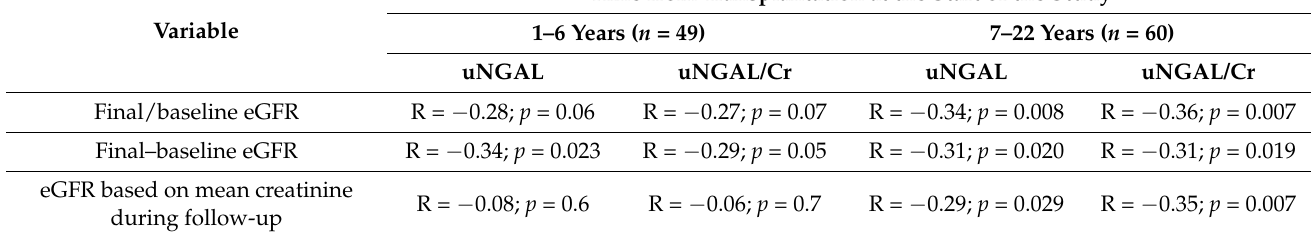
Table 4. Correlations between the baseline urine NGAL concentrations (uNGAL) and NGAL to creatinine ratios (uN ‐ GAL/Cr) and the changes in eGFR observed during the study as well as the eGFR based on mean serum creatinine during the follow ‐ up.